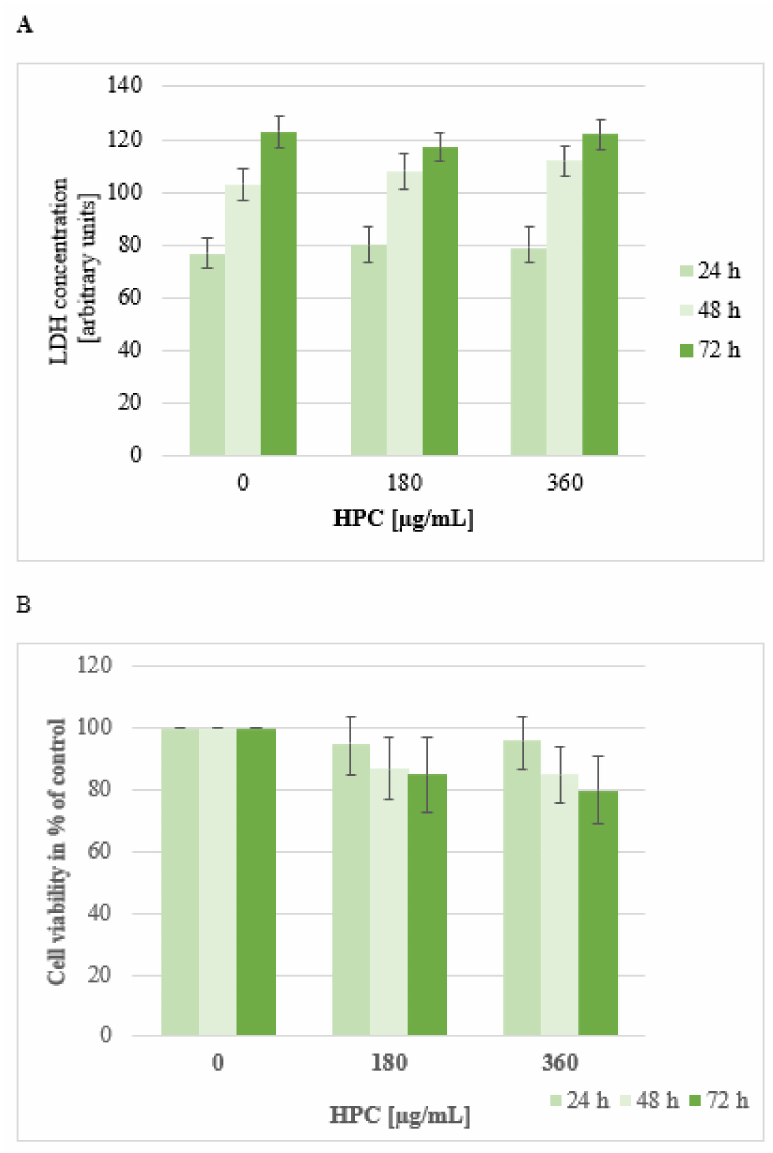
Figure 2. LDH-release ( A ) and MTT assay ( B ) using cultured cells from fibroblast cell line 3T3. Cells were treated with anti-hemorrhoidal polyherbal cream (HPC) (0, 180, and 360 µ g/mL) for 24 h, 48 h, and 72 h. Data shown represent the mean ± SEM from three independent experiments carried out in